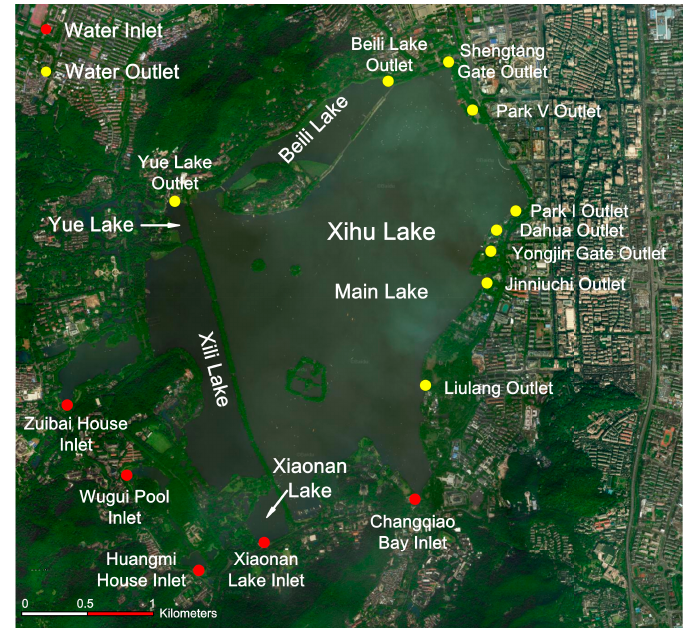
Figure 1. Shoreline features of Xihu Lake.